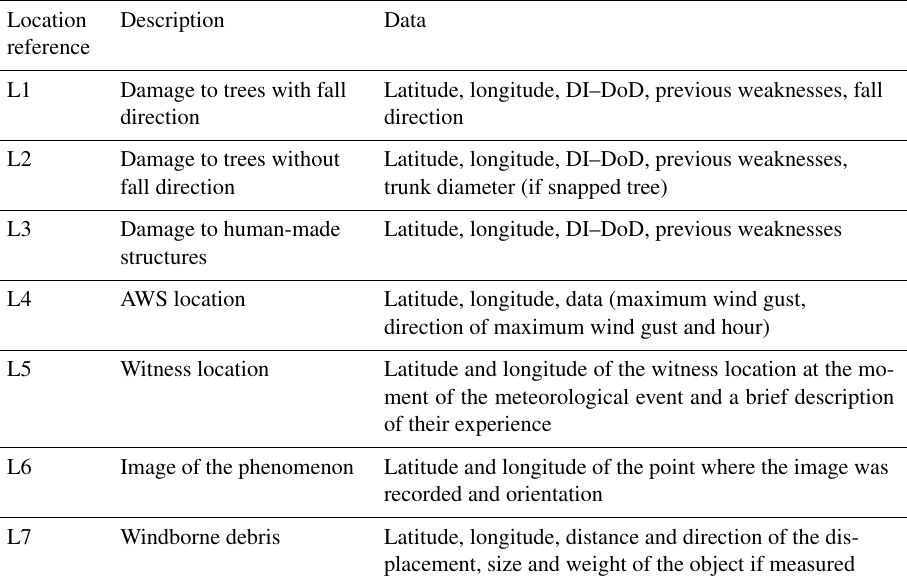
Table 4. Information location types (reference, description and data that should be presented). Location